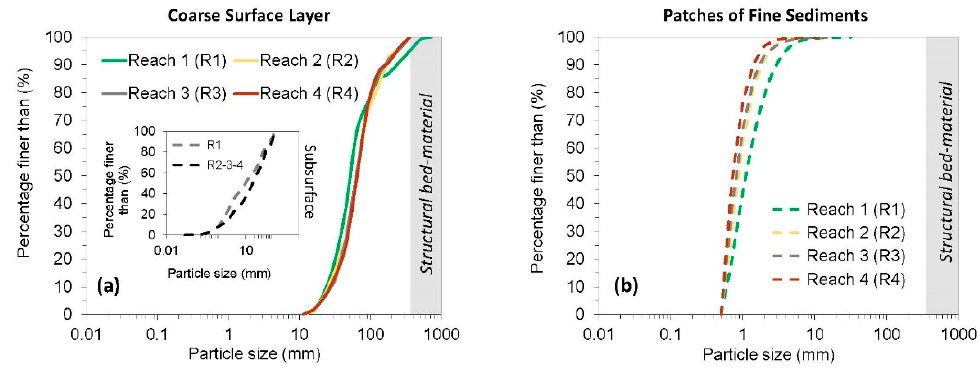
Figure 7. Grain-size distribution of the study reaches in the Noguera Pallaresa: ( a ) Coarse Surface Layer and Subsurface materials, and ( b ) Patches of Fine Sediments. Note that the range of sizes for the structural bed-material configuration is also identified in both distributions as reference.